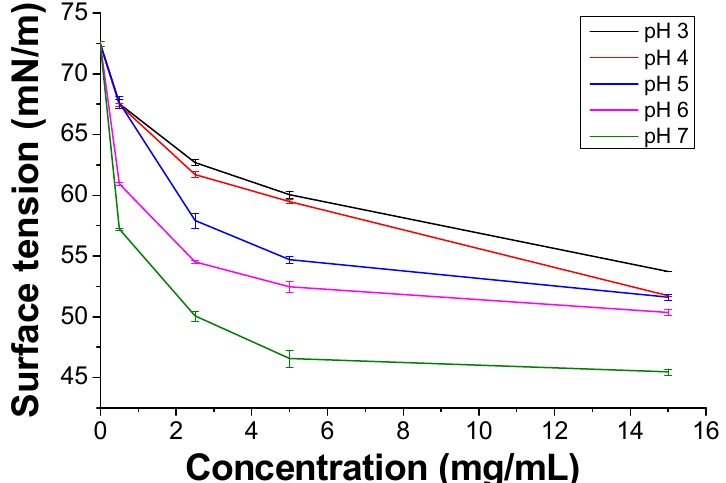
Figure 2. Surface tension of polyketone- N -(2-hydroxyethyl)ethylenediamine) (PKHEDA) as a function of the concentration at various pH values.